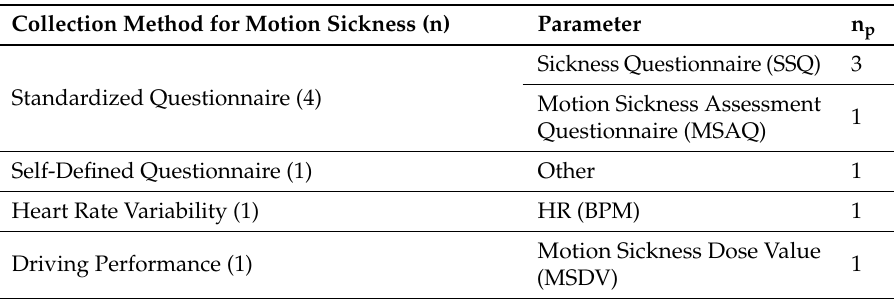
Table 17. Motion Sickness collection methods and